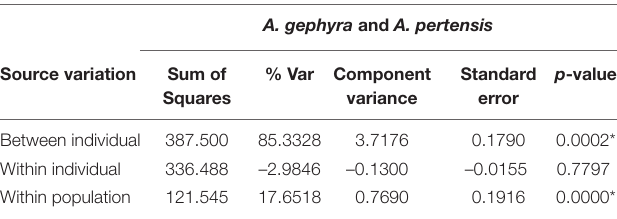
TABLE 2 | Upper diagonal: genetic distance; bottom diagonal of the bold: F ST and Nm (in parentheses), based on microsatellite data.